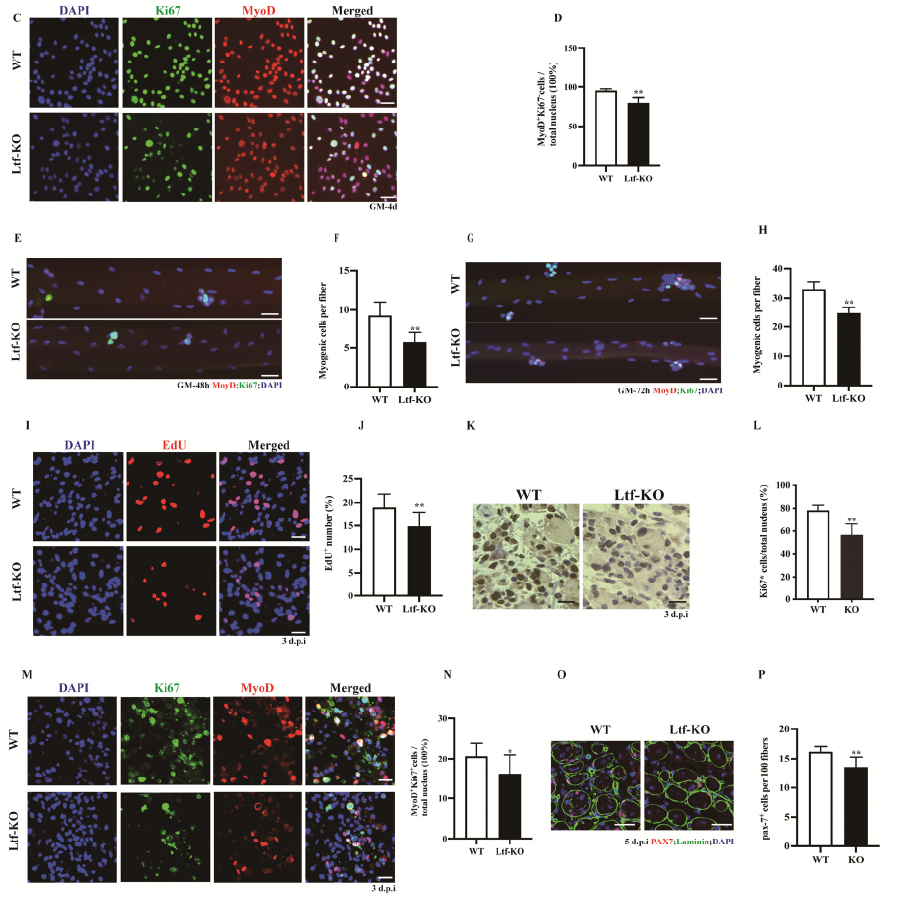
Figure 2. Deletion of Ltf reduces proliferative capability of SCs. ( A ) Representative individual and merged photomicrographs of SCs sorted from WT and Ltf -KO mice; cultured for 4 days; and labeled with EdU, Pax7, and DAPI. Scale bars: 30 µ m. ( B ) Quantitative analysis of the frequency of Pax7 + EdU + double-positive cells sorted from WT and Ltf -KO mice. ( C ) Representative individual and merged photomicrographs of SCs sorted from WT and Ltf -KO mice; cultured for 4 days; and co-stained with MyoD, Ki67, and DAPI. Scale bars: 30 µ m. ( D ) Quantification of the number of MyoD + Ki67 + double-positive cells sorted from WT and Ltf -KO mice. ( E ) Representative merged photomicrographs of 48 h cultured myofibers from WT and Ltf -KO mice co-stained with MyoD, Ki67, and DAPI. Scale bars: 30 µ m. ( F ) Quantification of myogenic cell number per myofiber. ( G ) Representative merged photomicrographs of 72 h cultured myofibers from WT and Ltf -KO mice co-stained with MyoD, Ki67, and DAPI. Scale bars: 30 µ m. ( H ) Quantification of myogenic cells number per myofiber. ( I ) Representative individual and merged images of day 3 post-injury TA muscles of WT and Ltf -KO mice, cells were labeled with EdU and DAPI. Scale bar: 30 µ m. ( J ) Quantification of the number of EdU + cells in day 3 post-injury TA muscles of WT and Ltf -KO mice. ( K ) Immunohistochemistry analysis of Ki67 + cells in regenerating muscle from WT and Ltf -KO mice at day 3 after injury. Scale bars: 30 µ m. ( L ) Quantification of the number and percentage of Ki67+ cells in regenerating TA muscle of WT and Ltf -KO mice. ( M ) Representative individual and merged images of day 3 post-injury TA muscles of WT and Ltf -KO mice, cells were labeled with MyoD, Ki67and DAPI. Scale bar: 30 µ m. ( N ) Quantification of the percentage of MyoD+Ki67+ double-positive cells among the total nuclei in injured TA muscle of WT and Ltf -KO mice. ( O ) Representative merged images of day 5 post-injury TA muscles of WT and Ltf -KO mice, cells were labeled with PAX7, Laminin and DAPI. Scale bar: 30 µ m. ( P ) Quantification of the percentage of PAX7-positive cells among the total nuclei in injured TA muscle of WT and Ltf -KO mice. n = 3 in each group. * p < 0.05; ** p < 0.01; *** p <